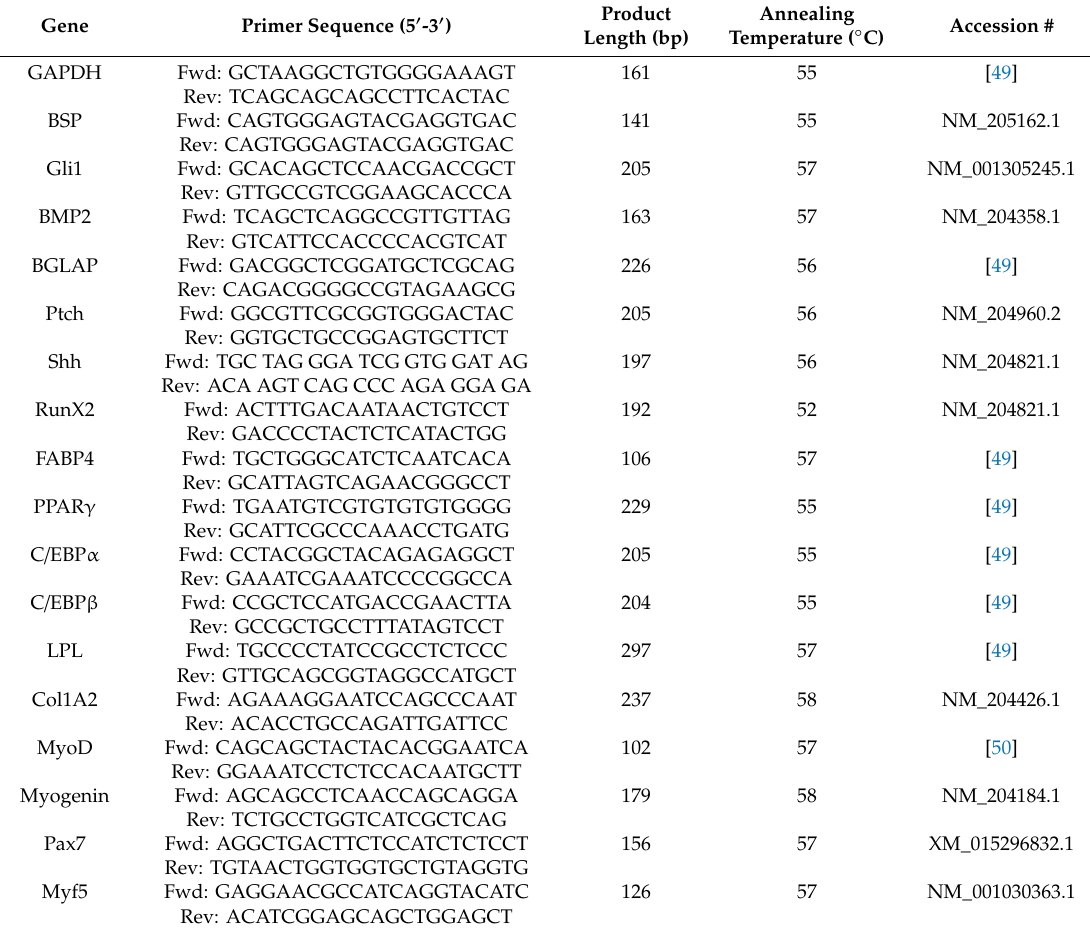
Table 1. Primers sequences that were used for qRT-PCR gene expression